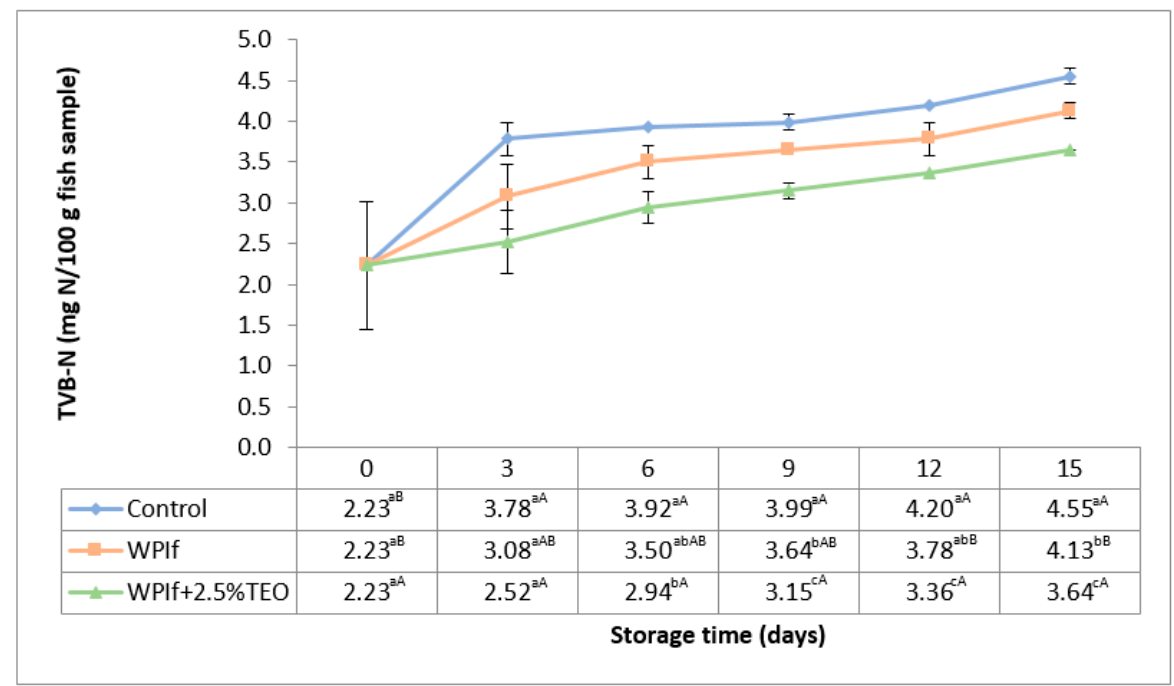
Figure 3. Changes in total volatile basic nitrogen (TVB-N) of brook trout samples during refrigerated storage. Control-uncovered fish samples; WPIf-fish samples covered with WPI-based films; WPIf+2.5%TEO-fish samples covered with whey protein isolate-based films incorporated with 2.5% tarragon essential oil. Values are expressed as mean ± standard deviation of three replicates. Means that do not share a letter (lowercase letters on column and uppercase letters on row) are significantly different.